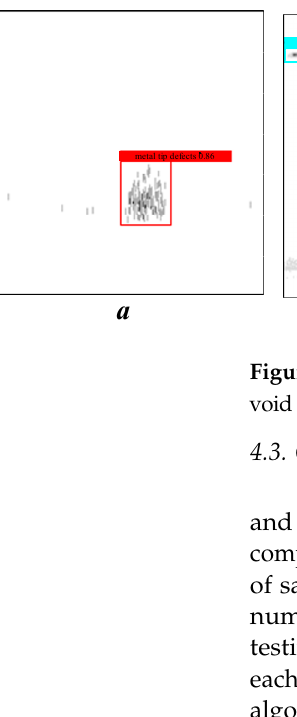
26.53 Figure 10. Loss curves for model training and validation. By analyzing the effects of the detection environment and training techniques of the YOLOv5 algorithm on the testing effect of the GIS partial discharge defect detection model, the GIS partial discharge detection model under the optimal parameter settings